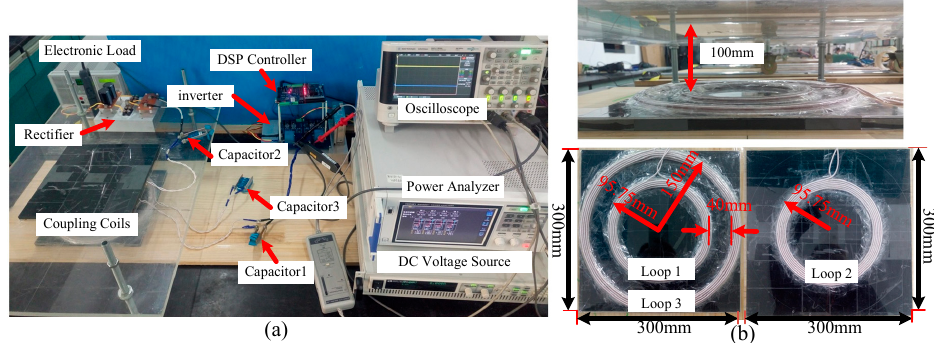
Figure 5. ( a ) Prototype of the 3-coil system ( b ) Resonant tank of the 3-coil system.